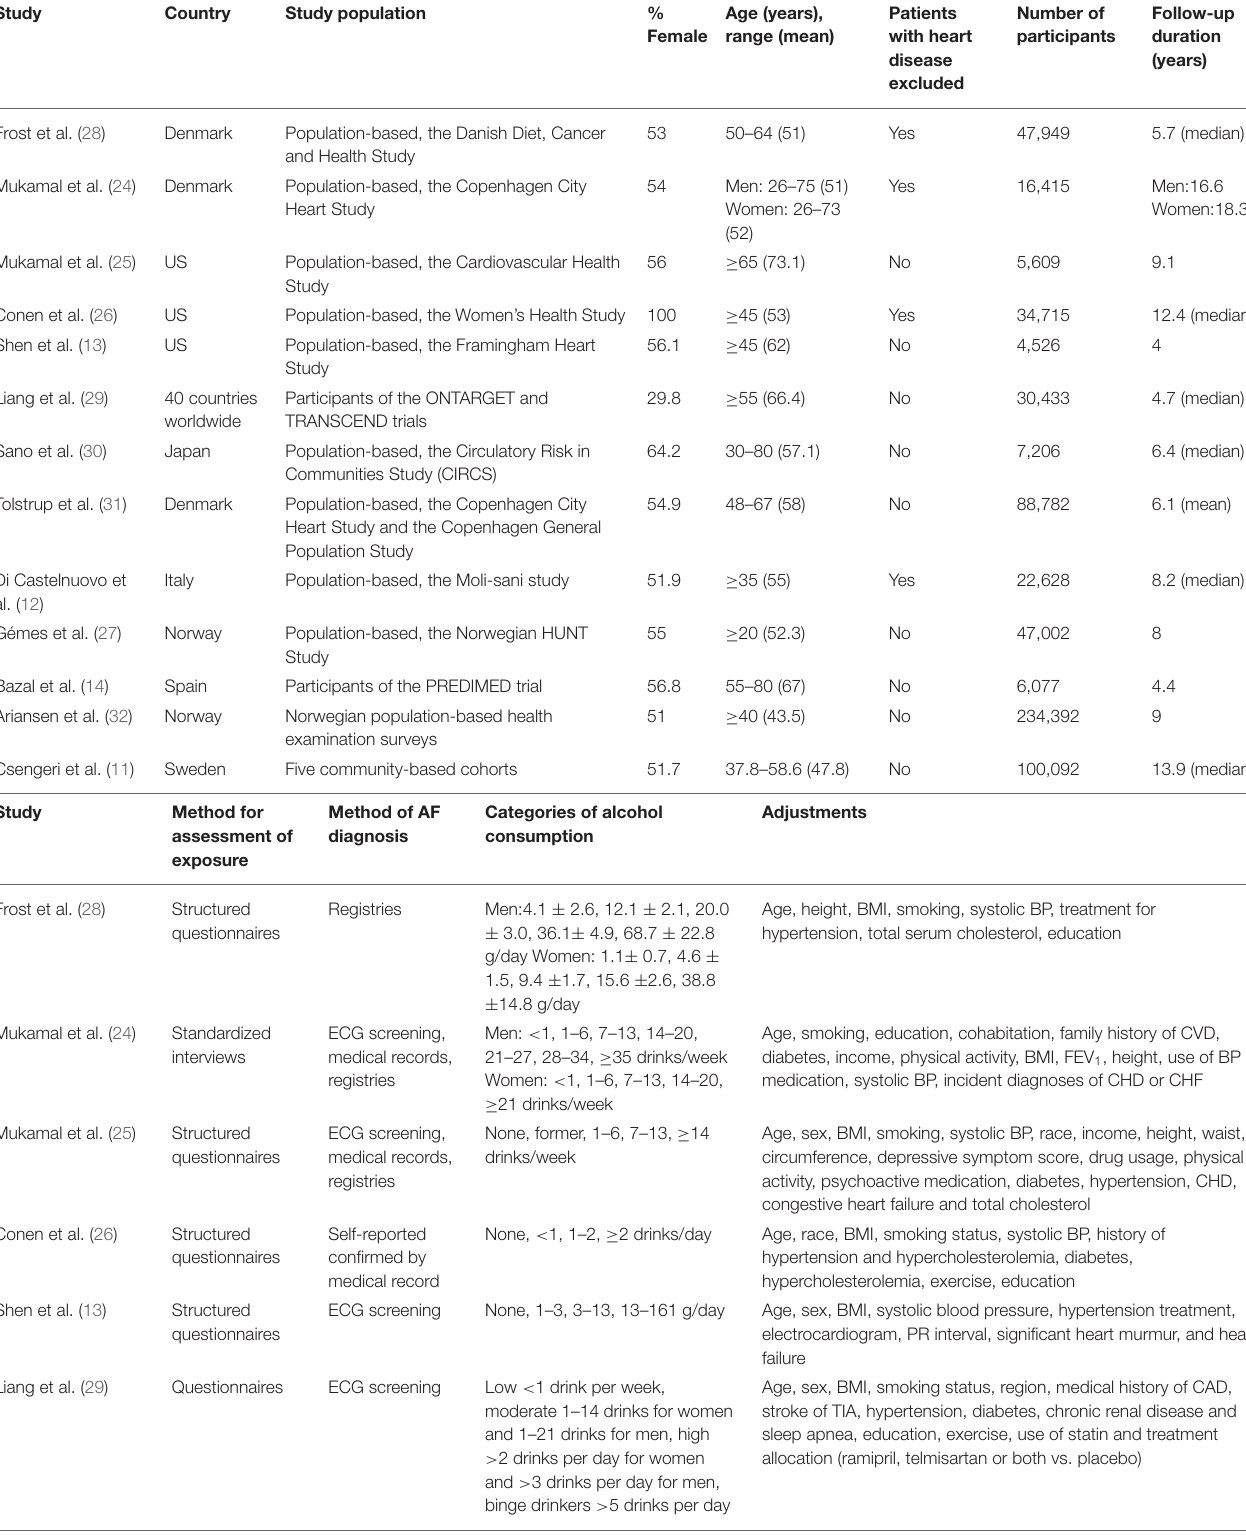
TABLE 1 | Characteristics of the studies included in the meta-analysis. Study Patients